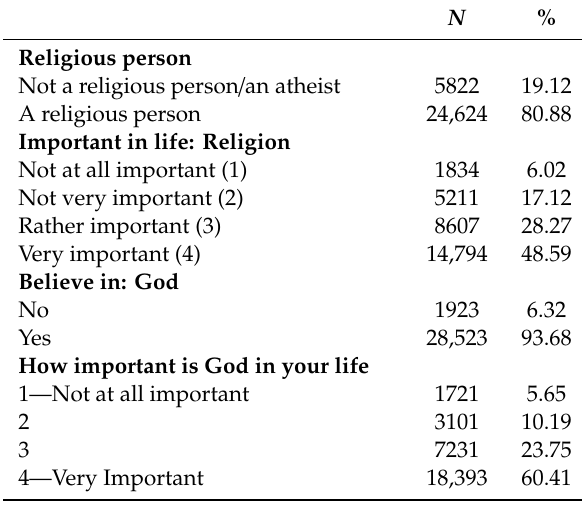
Table 4. Distribution of frequencies relating to religious identity.